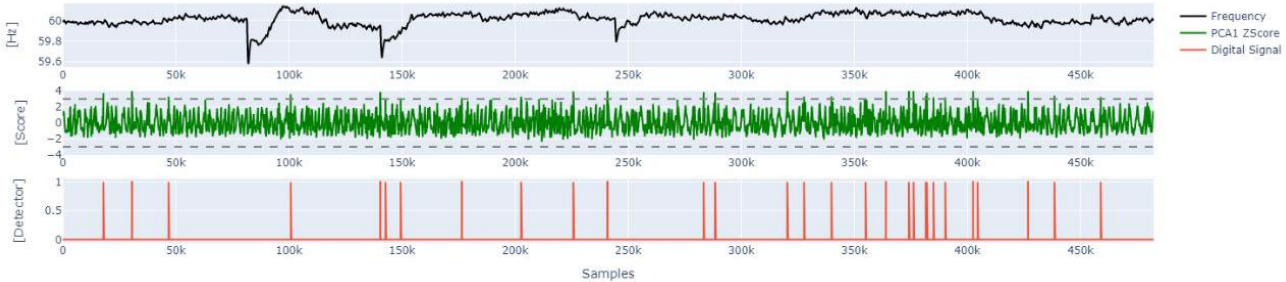
Figure 13. Event 2: detector event of PMU Apucarana (located at north of Parana State).